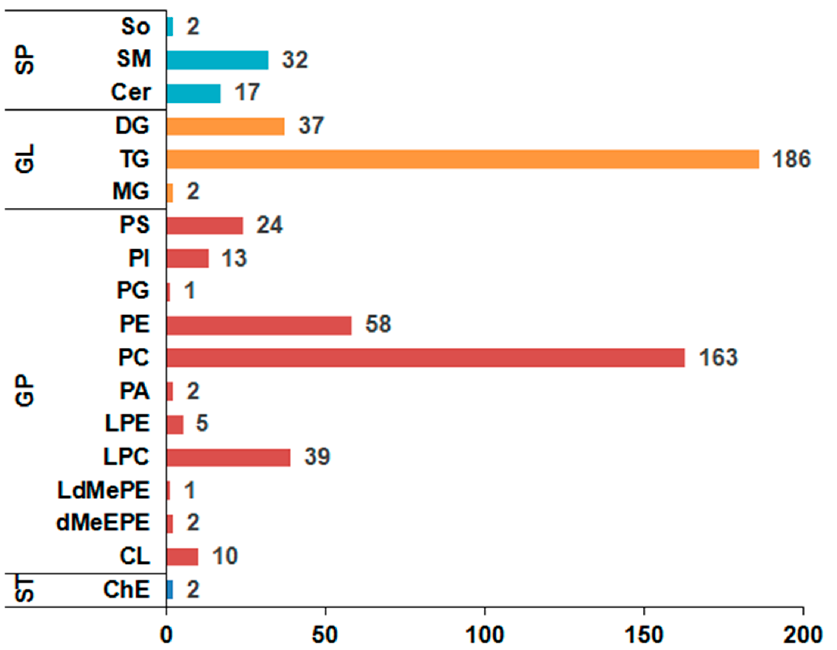
Figure 1. The column chart of the lipid classification in yak longissimus dorsi (LD). Column length represents the number of lipids. ST represents sterol lipid; SP represents sphingolipid; GL represents glycerolipid; GP represents glycerophospholipid; Cer represents ceramide; ChE represents cholesteryl ester; DG represents diglyceride; CL represents cardiolipin; dMeEPE represents dimethylphosphatidylethanolamine; LPC represents lyso-phosphatidylcholine; LdMePE represents lyso-dimethylphosphatidylethanolamine; LPE represents lyso-phosphatidylethanolamine; MG represents monoglyceride; PA represents phosphatidic acid; PC represents phosphatidylcholine; PE represents phosphatidylethanolamine; PG represents phosphatidylglycerol; PI represents phosphatidylinositol; PS represents phosphatidylserine; SM represents sphingomyelin; So represents sphingosine; TG represents triacylglycerol. The Loading-PAC of SDLs in yak LD under GF and SF (Figure 2c) showed that the variance contribution rates of principal component 1 (PC1) and principal component 2 (PC2) were 75.52 and 11.25%, respectively, and the aggregate value was 86.77%. PE(18:0/22:4), PE(18:0/22:5), PC(18:2/18:0), TG(18:1/18:1/18:2), TG(18:0/18:1/18:1), PI(18:0/22:5), TG(16:0/16:1/18:1), TG(16:0/17:1/18:1), TG(16:1/18:1/18:1), PI(18:0/20:4), PE(18:1/18:1), PE(16:0/22:6) and TG(16:1/16:1/18:1) played an important role in the lipid differences between SF and GF yak LD from the angle of PC1; TG(17:0/18:1/18:1) and PE(18:0/22:5) played an important role in the lipid differences between SF and GF yak LD from the angle of PC2. The information on crucial lipids resulting in the lipid differences in yak LD between GF and SF is shown in Table